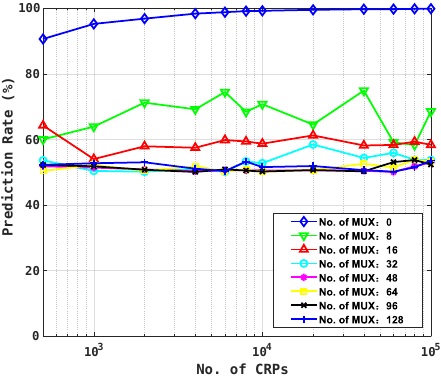
Figure 9. LR attack results on the MMPUF design with different numbers of